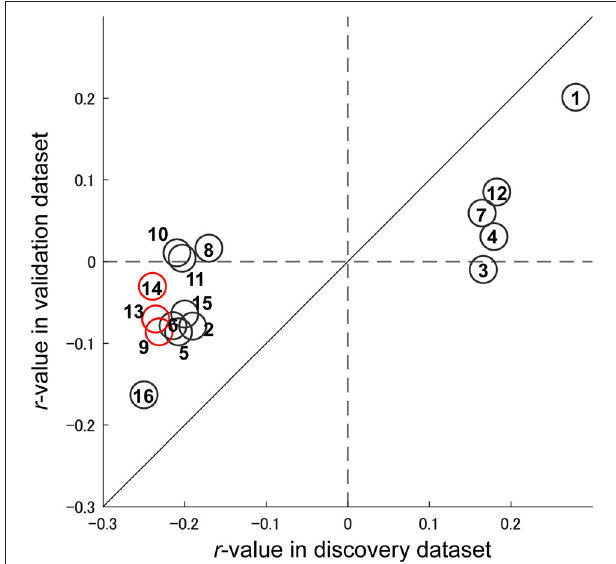
FIGURE 5 | Reproducibility of important FCs regarding symptom effects. Scatter plot of the depression symptom effect size (Pearson’s correlation between BDI-II and FC strength: r -value). Each circle represents the symptom effect in the discovery dataset in the abscissa and that for the validation dataset in the ordinate for each FC. Red circles indicate common FCs between the major depressive disorder diagnosis and depression symptoms models. The number in the circle is the number of the FC, as in Figure 4 and Supplementary Table 3